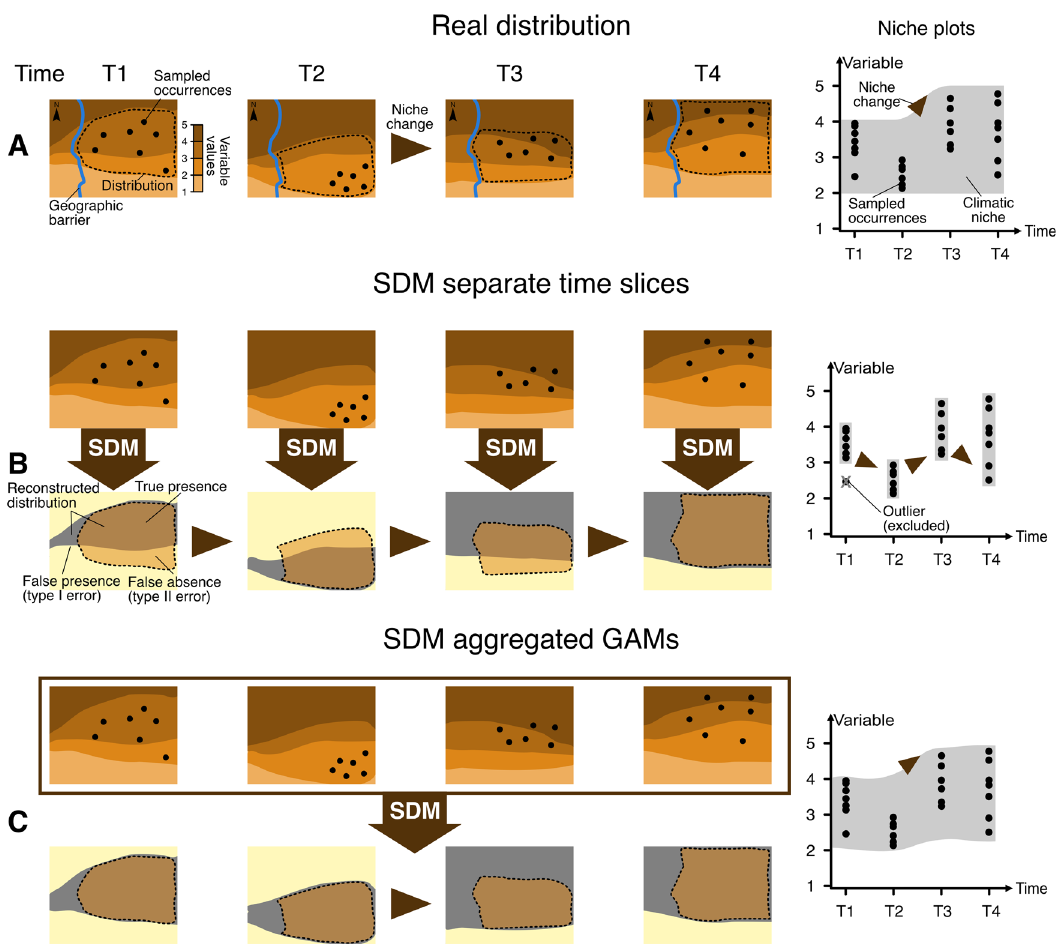
Fig. 1 Schematic description of how different Species Distribution Modelling (SDM) approaches deal with diachronic data. A Map of the actual distribution of a species (dotted line) through time in four different periods (T1 – T4). Sampled occurrences are depicted as black points, and different values of the climatic variable are shown as different colour shades. On the right side, a niche plot shows how the niche (grey shading, with the x -axis representing a climatic variable of interest) varies through time ( y -axis); and where occurrences are located within the niche space. Sections ( B ) and ( C ) show the different reconstructions of the distribution and niche changes for an SDM done separately over each time slice ( B ) and our aggregated GAM method presented in this work ( C